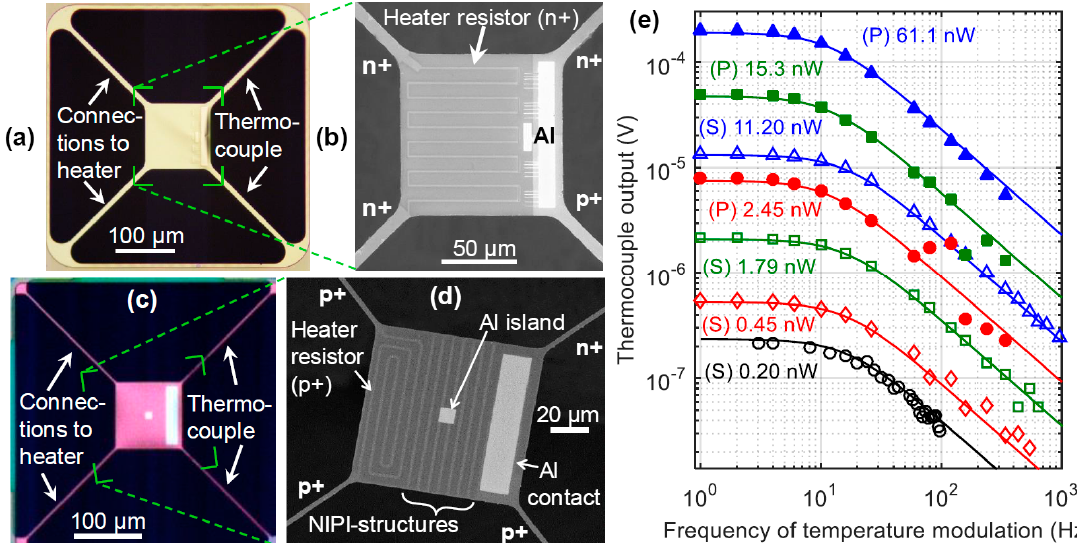
Figure 2. ( a – d ) Optical ( a , c ) and scanning-electron ( b , d ) micrographs of device S ( a , b ) [1] and device